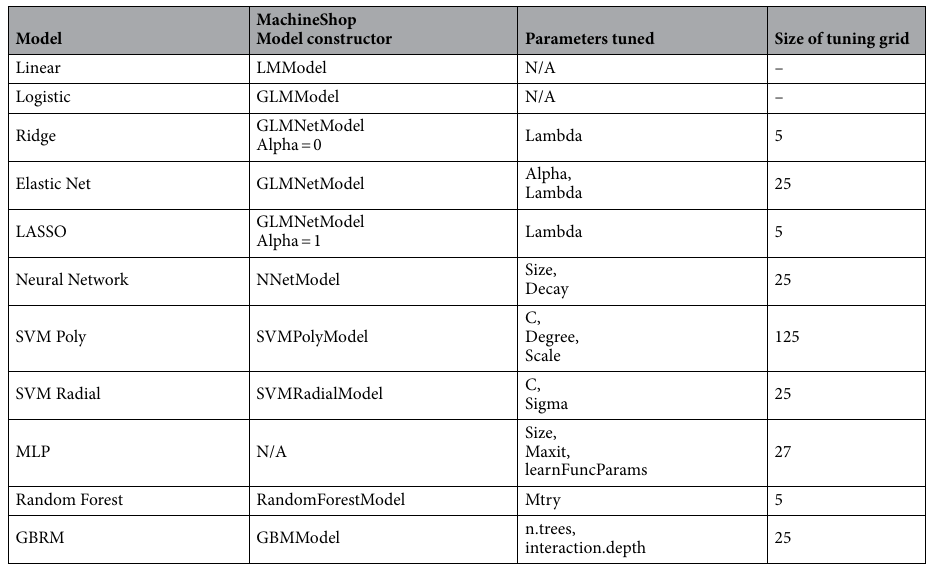
Table 5. Summary of tuning for each model. LASSO: (least absolute shrinkage and selection operator); SVM Poly: support vector machine with a polynomial kernel; SVM Radial; MLP: multi-layer perceptron; LMModel: linear model; GLMModel: generalized linear model; GLMNetModel: generalized linear model with penalized maximum likelihood; NNetModel: feed-forward neural networks; GBMModel: generalized